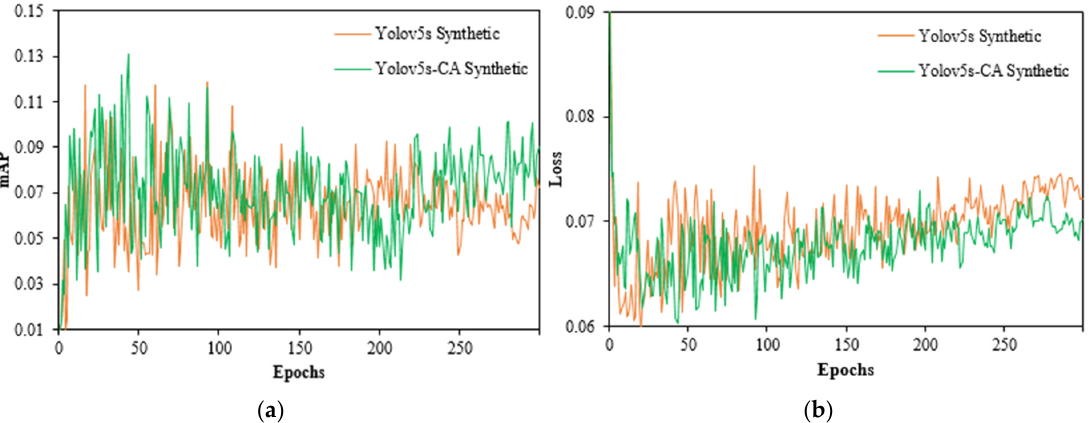
Figure A1. Experimental results of each model on the field-collected dataset. ( a ) mAP @0 . 5 curves for the real field dataset. ( b ) Loss curves for the real field dataset.